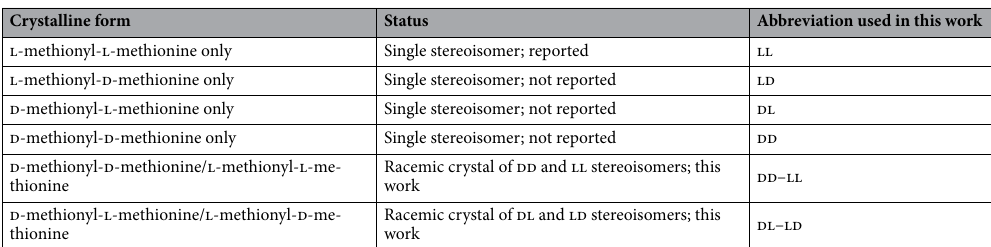
Table 1. The six possible crystalline forms of